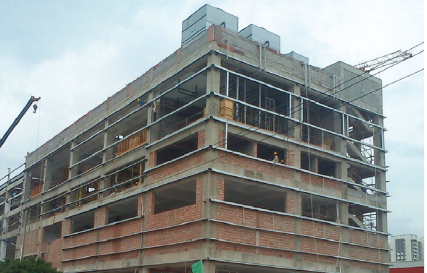
Figure 2: Three-dimensional view of industrial